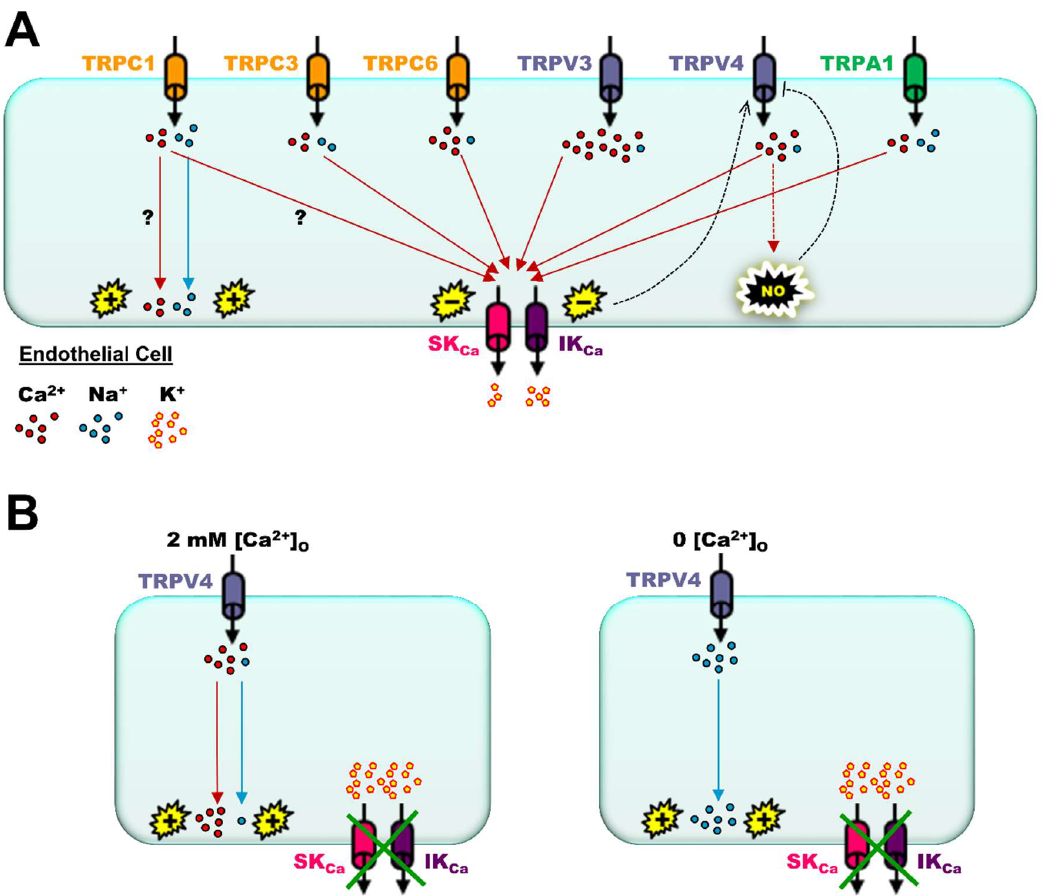
Figure 2. Functional contribution of major transient receptor potential (TRP) channel isoforms to activation of small- and intermediate-Ca 2+ -activated K + (SK Ca and IK Ca ) channels and endothelium-derived hyperpolarization. ( A ) Permeability of Ca 2+ to Na + ions (P Ca /P Na ) varies across the canonical (TRPC), vanilloid (TRPV), and ankyrin families of TRP channels. However, with the exception of TRPC1, endothelial TRP channels underlie significant influx of Ca 2+ to activate SK Ca and IK Ca channels. As discussed in the text, note that these individual TRP isoforms can form tetrameric TRP channels via heteromeric combinations (e.g., TRPV4–TRPC1, TRPC3–TRPC4) in a physiological setting that may not be representative of determinations of homomeric channels expressed in heterologous culture systems. As it relates to the competition with Na + influx, the “?” symbol indicates the unknown contribution of Ca 2+ influx through TRPC1-containing channels for V m depolarization vs. activation of SK Ca and IK Ca channels for V m hyperpolarization as both are theoretically possible. Hyperpolarization via activation of SK Ca /IK Ca channels may stimulate Ca 2+ influx through TRPV4-containing channels for further activation of SK Ca and IK Ca channels and production of NO (“positive” feedback; broken black arrow). Although, nitric oxide (NO) may inhibit TRPV4-containing channels (“negative” feedback) via S -nitrosylation (broken black line with flat end). ( B ) In the absence of functional SK Ca and IK Ca channels, Ca 2+ and Na + influx (P Ca /P Na ~6:1; extracellular Ca 2+ ([Ca 2+ ] o ) present) through TRPV4-containing channels leads to endothelial depolarization ( left panel ). In the absence of [Ca 2+ ] o , Na + influx through TRPV4 channels is robust, and depolarization occurs regardless of SK Ca and IK Ca channel presence and function ( right panel ). Green crosses over SK Ca and IK Ca channels denote their functional absence in the plasma membrane (e.g., collecting lymphatic endothelium). For all panels, ( − ) and (+) symbols indicate V m hyperpolarization and depolarization respectively while the respective color of lines corresponds to Ca 2+ (red) or Na + (light blue) signaling. All lines with arrow ends indicate positive signaling of respective ions to ultimately effect a change in V m (hyperpolarization or depolarization) or production of